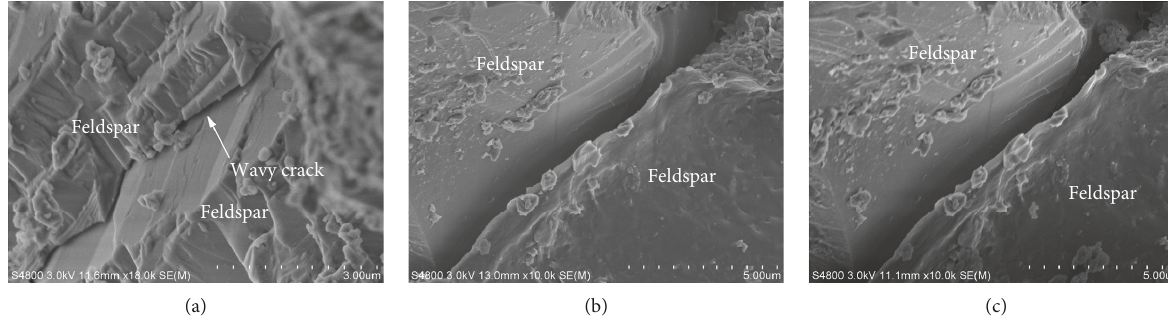
Figure 10: Feldspar crack propagation graph.